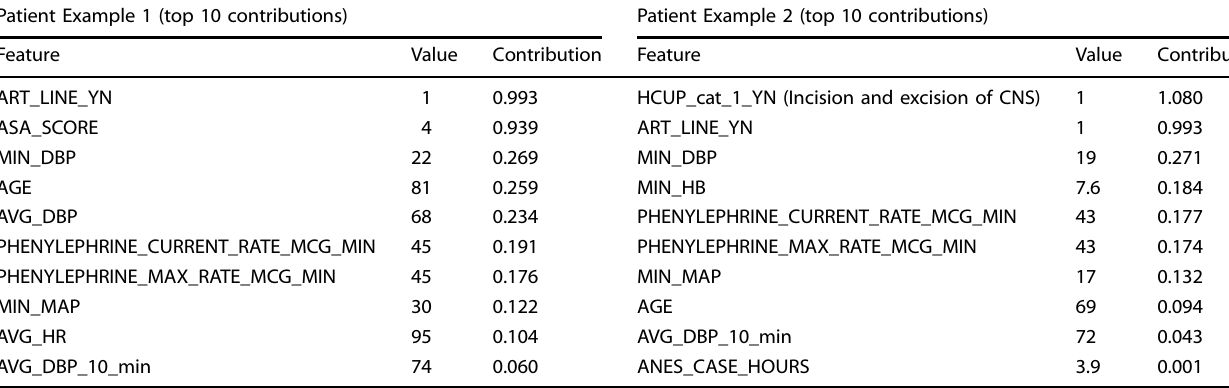
Table 4. Top 10 neural network contributions learned from the best-performing Generalized Additive Models with Neural Networks (GAM-NNs) model with HCUP features, for two in-hospital mortality patient examples from the test set. Patient Example 1 (top 10